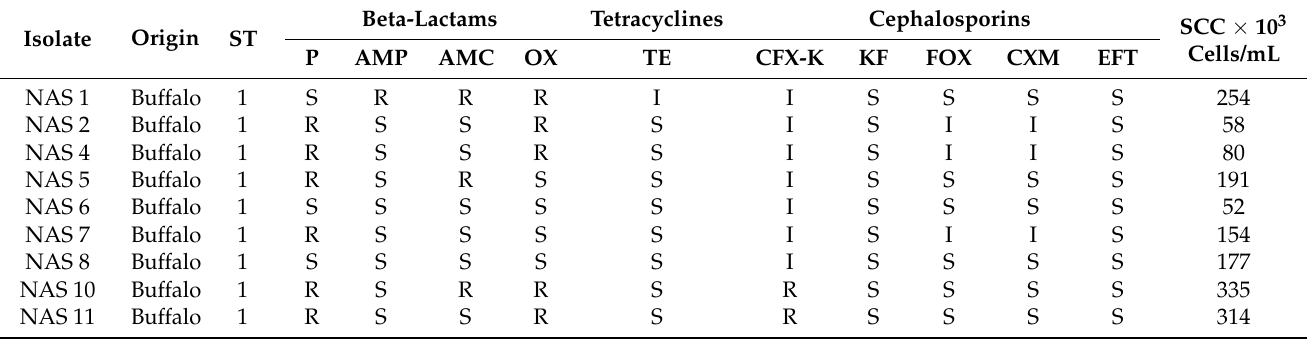
Table 1. Antibiotic patterns (disc method) per product and somatic cell count (SCC) × 10 3 cells/mL of milk for each isolate of S. simulans indicating the species of animal and sequence type of